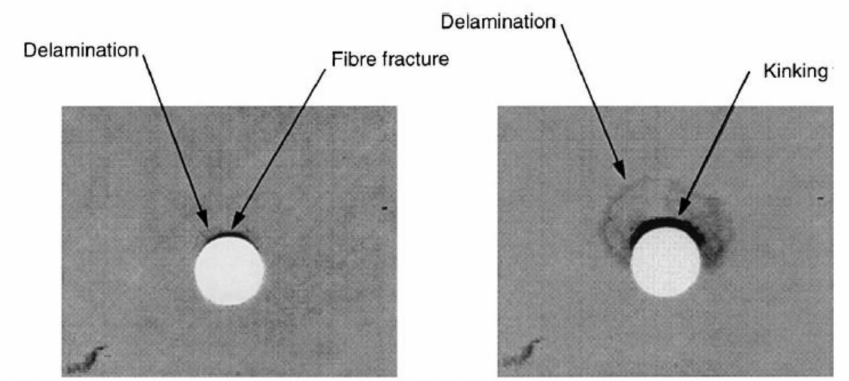
Figure 11. X-ray images of carbon / epoxy bolted joints after loading to di ff erent levels and disassembling